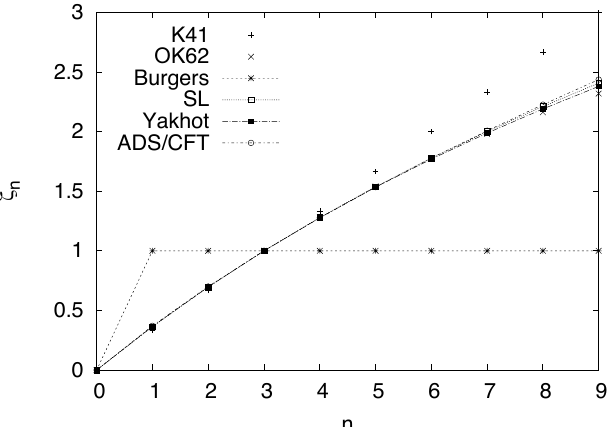
Figure 1. Scaling exponents ζ n of velocity structure functions for the different phenomenologies discussed in (i.)–(vi.) . The crosses that are arranged on the straight n /3-line correspond to the self-similar K41 phenomenology (i.) . Burgers phenomenology (iii.) exhibits the strongest